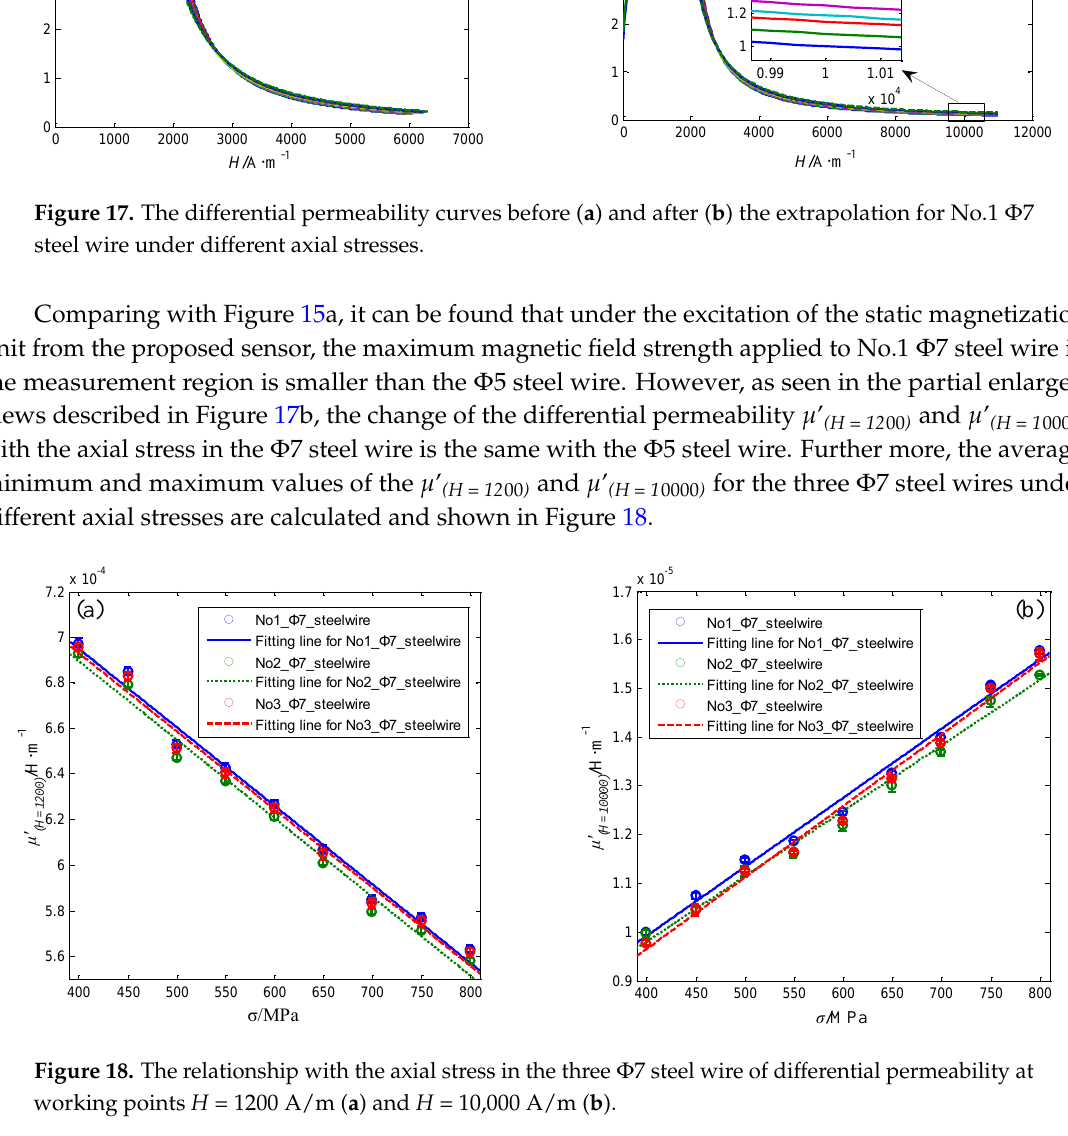
Table 4. The fitting function and R-square of fitted curves μ ’ (H = 12 00 ) (σ) and μ ’ (H = 1 0000 ) (σ) for different Φ7 steel wires.